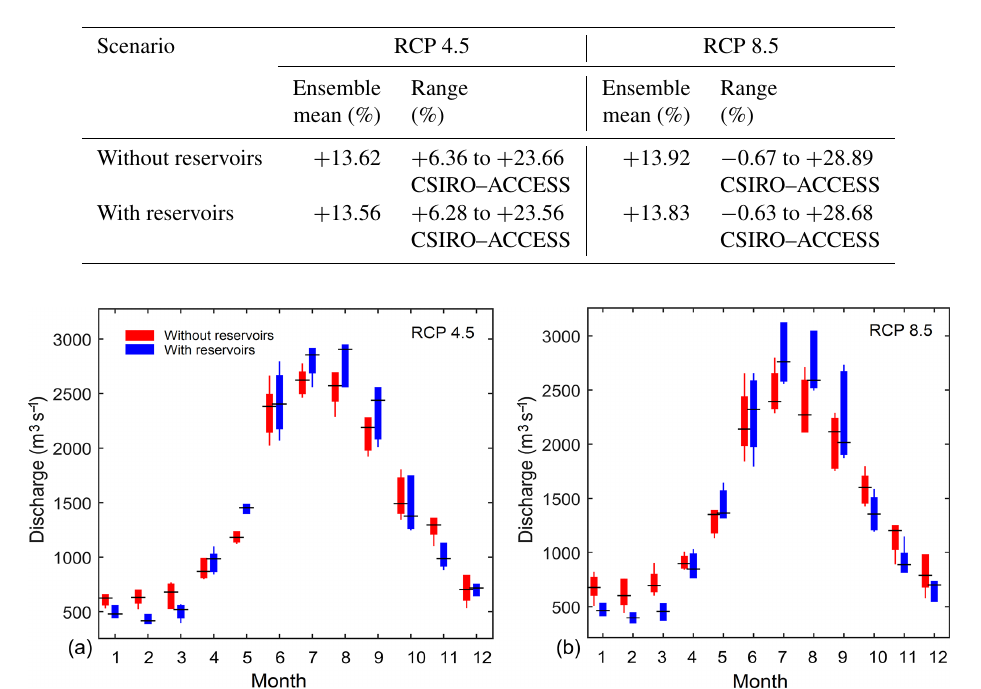
Table 4. Relative changes in annual river discharges at the Chiang Saen station for the future period (2050–2060) relative to the reference one (1996–2005). The lowest and highest changes are presented with the corresponding scenarios. The results reported in the first and second rows were produced by the selected models without and with reservoirs.